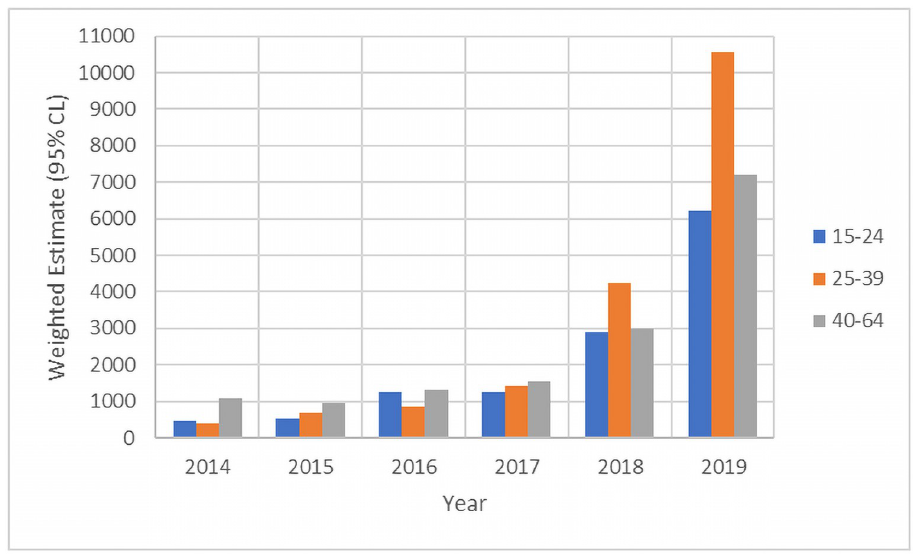
Fig 1. Trends in weighted incidence of electric scooter-related injuries seen in emergency departments in the United States from 2014 to 2019 by selected age groups [4].